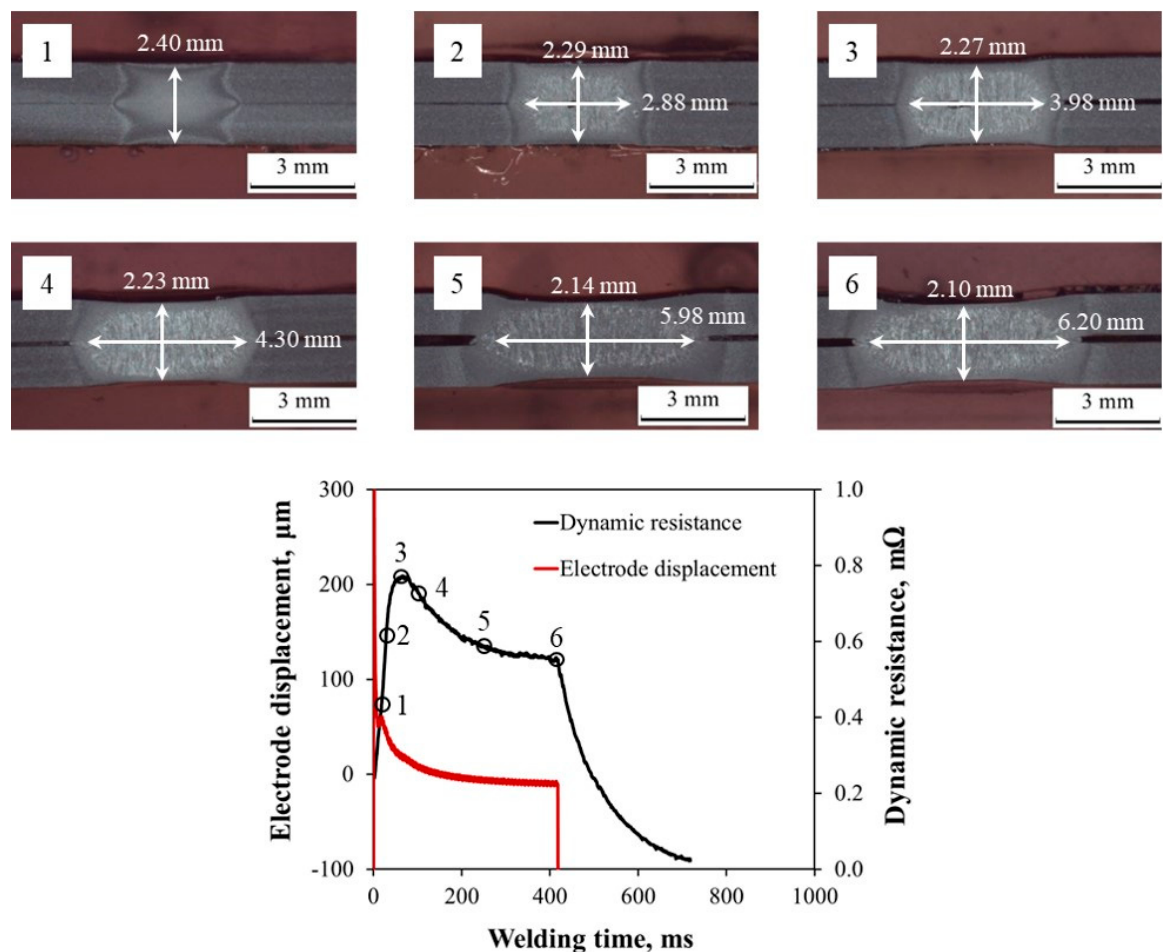
Figure 4. Independent variables of ( a ) electrode displacement and ( b ) dynamic resistance.